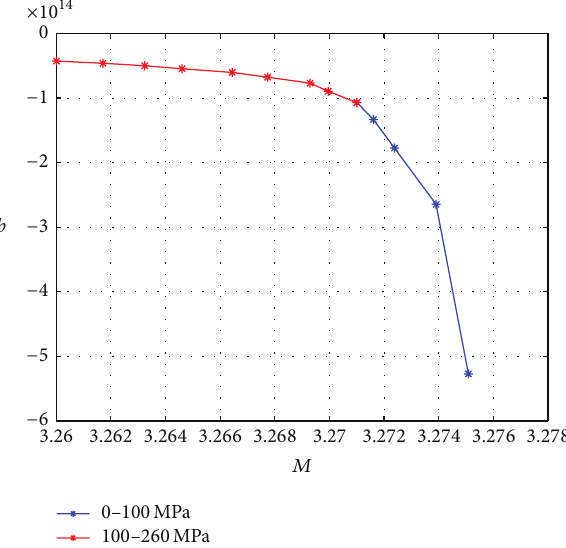
Figure 4: The fitting curve 𝑀 - 𝑏 of a 4.8 low-carbon steel bolt.